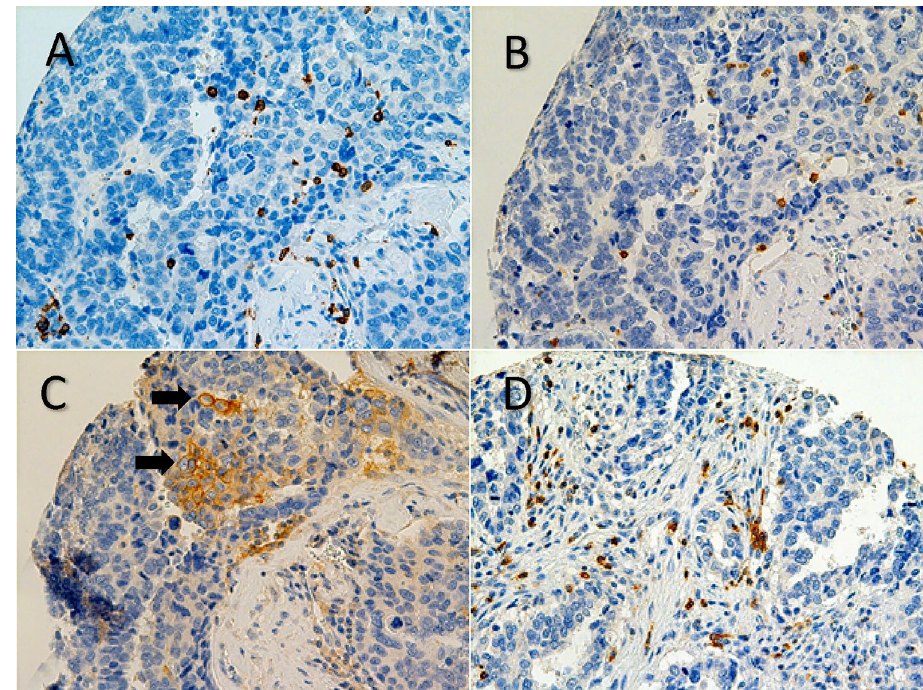
Figure2. ( A ) Representative immunohistochemistry (IHC) of CD8 in high grade serous ovarian cancer, 40 × : CD8 positive tumor infiltrating lymphocytes (TILs) ( B ) IHC of PD-L1, 40 × : PD-L1 positive TILs. ( C ) IHC of PD-L1, 40 × : tumor cells stain positively for PD-L1, membrane staining was observed. ( D ) IHC of PD-1, 40 × : PD-1 positive